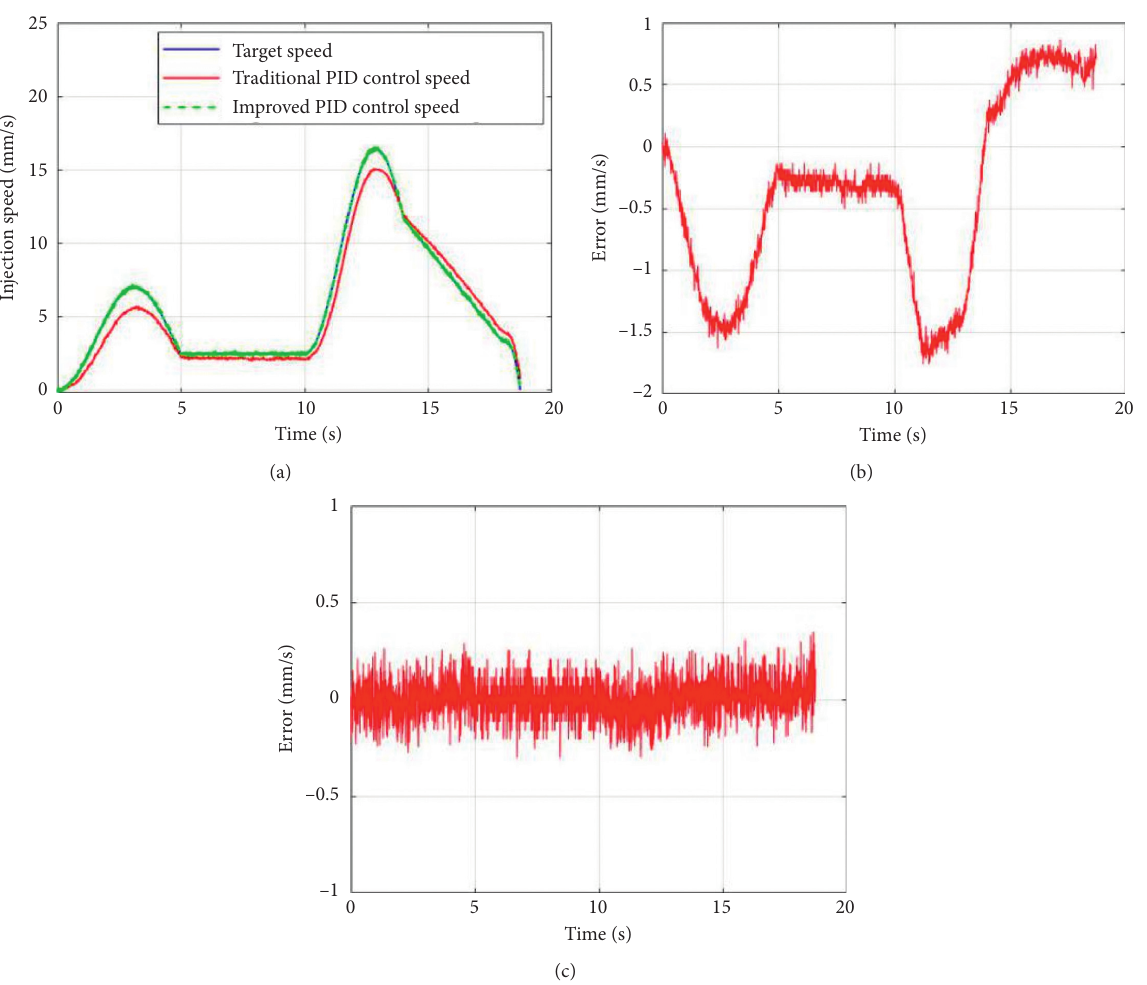
Figure 10: Random wave response test. (a) Comparison of three speed curves. (b) The error of traditional PID control. (c) The error of improved PID